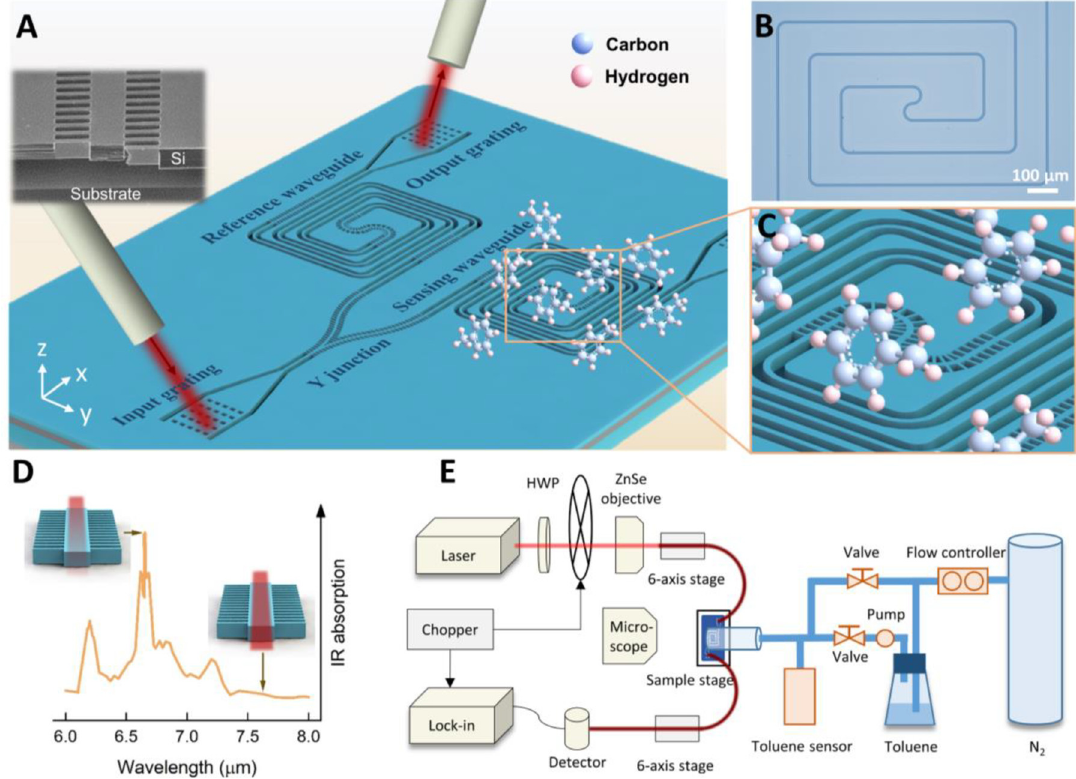
Figure 1: (A) Schematic illustration of the suspended Si waveguide gas sensing platform, consisting of grating couplers, tapers, a power splitter (Y-junction), and spiral waveguides. Inset: cross-sectional scanning electron microscope (SEM) image of the waveguide. (B) Optical image of the suspended Si spiral waveguide. (C) Zoom-in view of the sensingwaveguidesurroundedby toluene molecules as indicatedby the yellowsquareboxinFigure1A.(D)Absorptionspectrumoftoluenein6 – 8µmwavelengthrange.(E)Gassensingtestingsetupconsistingofan optical characterization module and a gas regulation module. The red lines show the light path (light red: in free space; dark red: in fi bers). HWP: half-wave